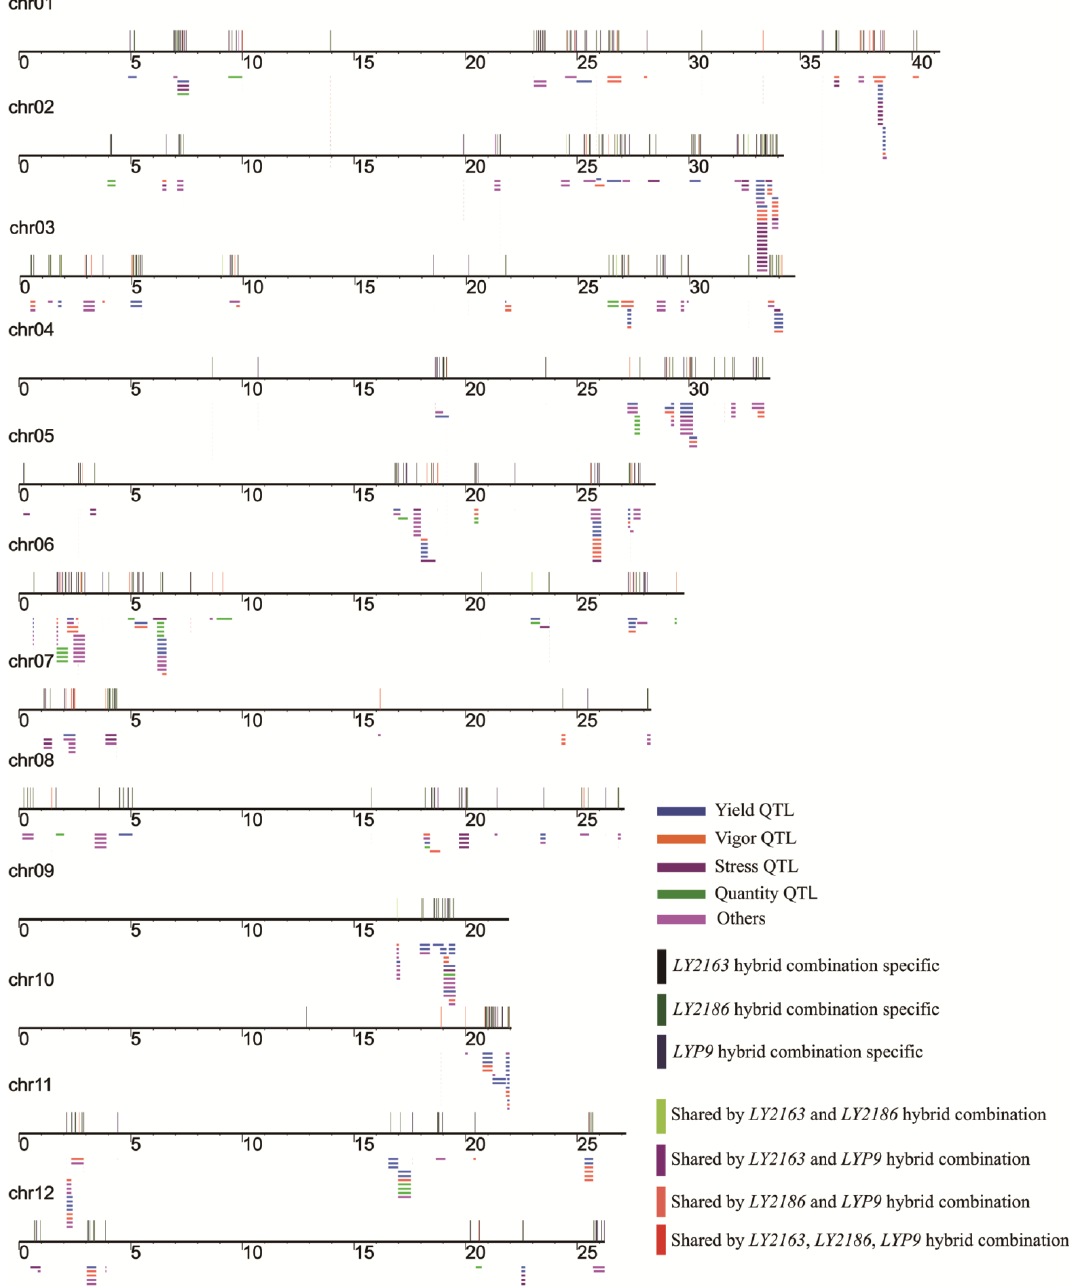
Figure 6. Distribution of DGs among QTLs of a small interval. QTLs in Gramene (number of harbored genes ≤ 100) and harbored DGs were aligned to the Michigan State University (MSU) Rice Genome Release 6.1. The long horizontal line represents 12 chromosomes of the rice genome; the short horizontal lines represent the QTL span, and short vertical lines represent